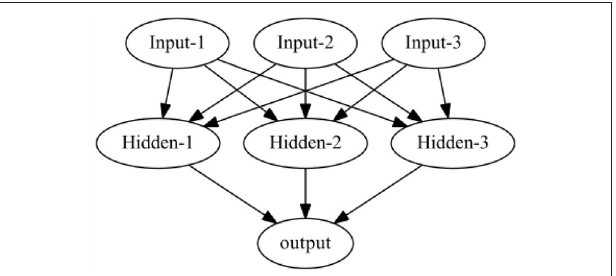
TABLE 13 | A summary of model parameters (3-layer-neural network) .